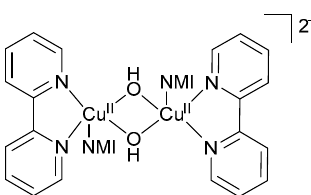
Figure 2. Formation of hydroxo-bridged binuclear Cu II -dimeric species during the aerobic alcohol oxidation reaction, as proposed by the groups of Koskinen and Stahl [11,28]. Copyright Wiley Materials, 2009 and American Chemical Society, 2013.